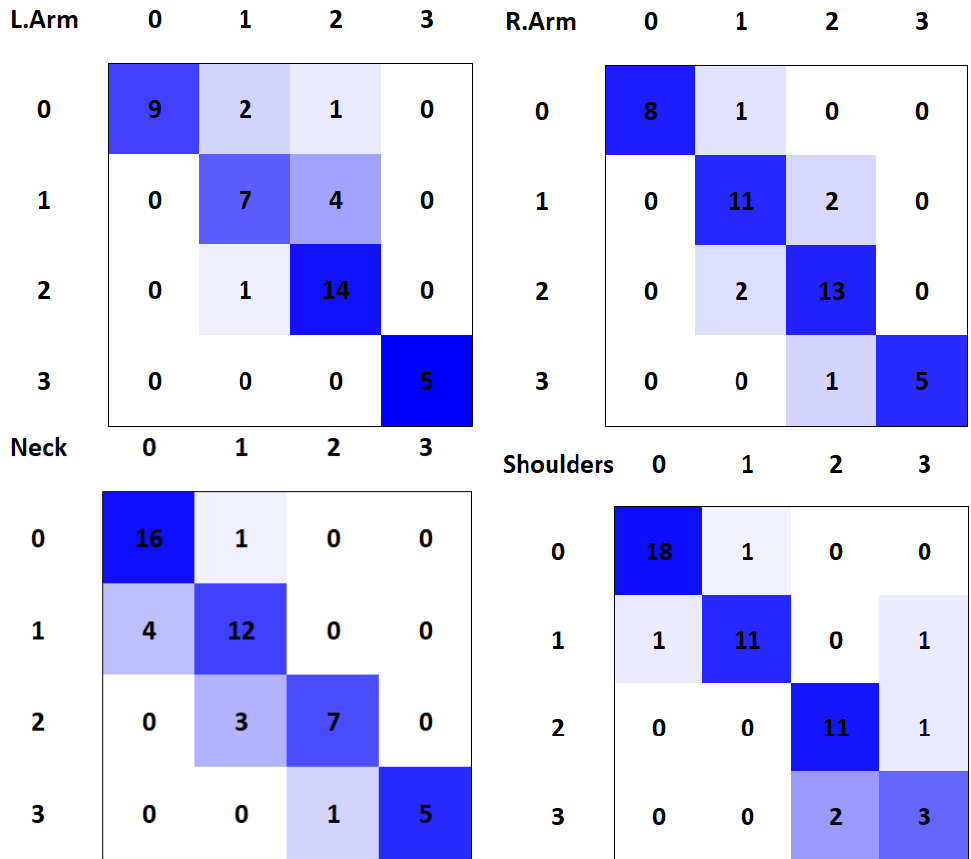
Figure 5. Confusion matrices for right arm abduction ( top left ) left arm abduction ( top right ) neck lateral bend ( bottom left ) and shoulder alignment ( bottom right